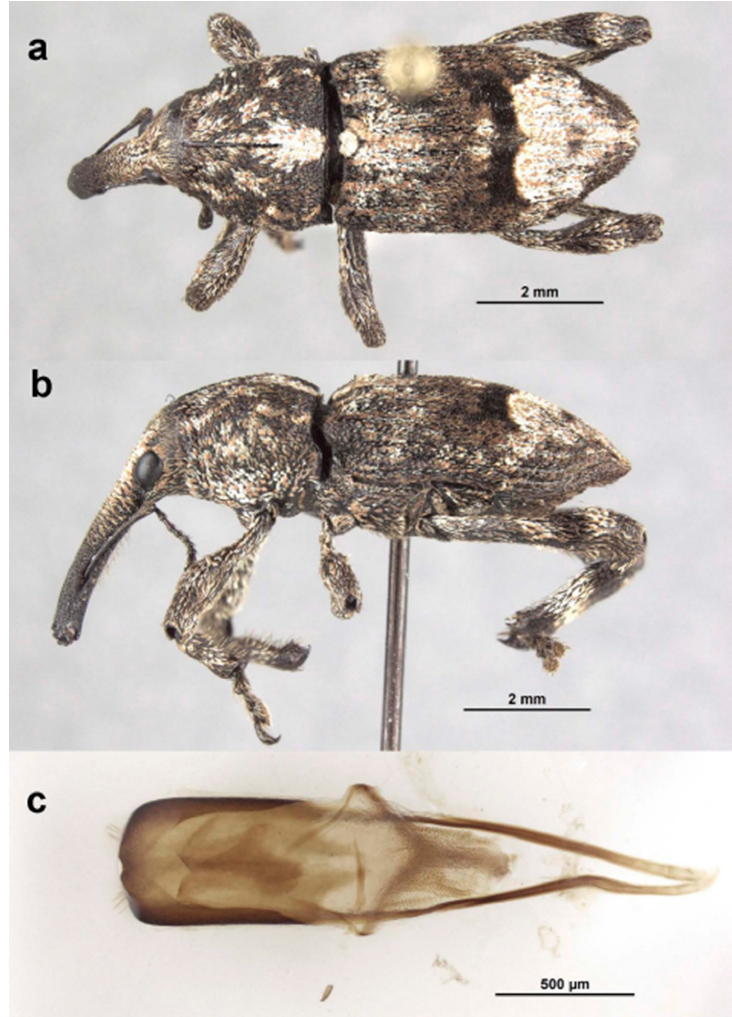
Figure 10. Ilacuris suttoni : ( a ) habitus of male, dorsal aspect; ( b ) habitus of male, lateral aspect; ( c ) aedeagus, dorsal aspect.